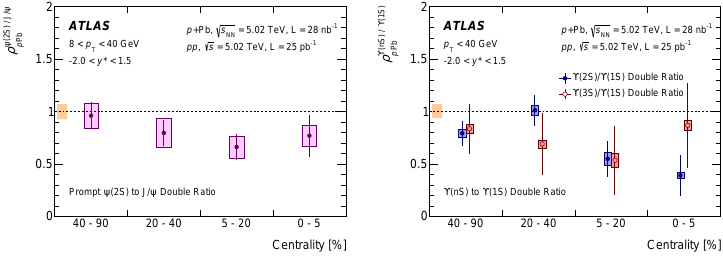
Figure 6. The double ratio ρ n S / 1S for (left) prompt charmonium and (right) bottomonium as a function p Pb of the collision centrality in the kinematic ranges indicated on the plots. The vertical size of the leftmost box corresponds to the total uncertainty of the pp reference. Figures are taken from Ref.